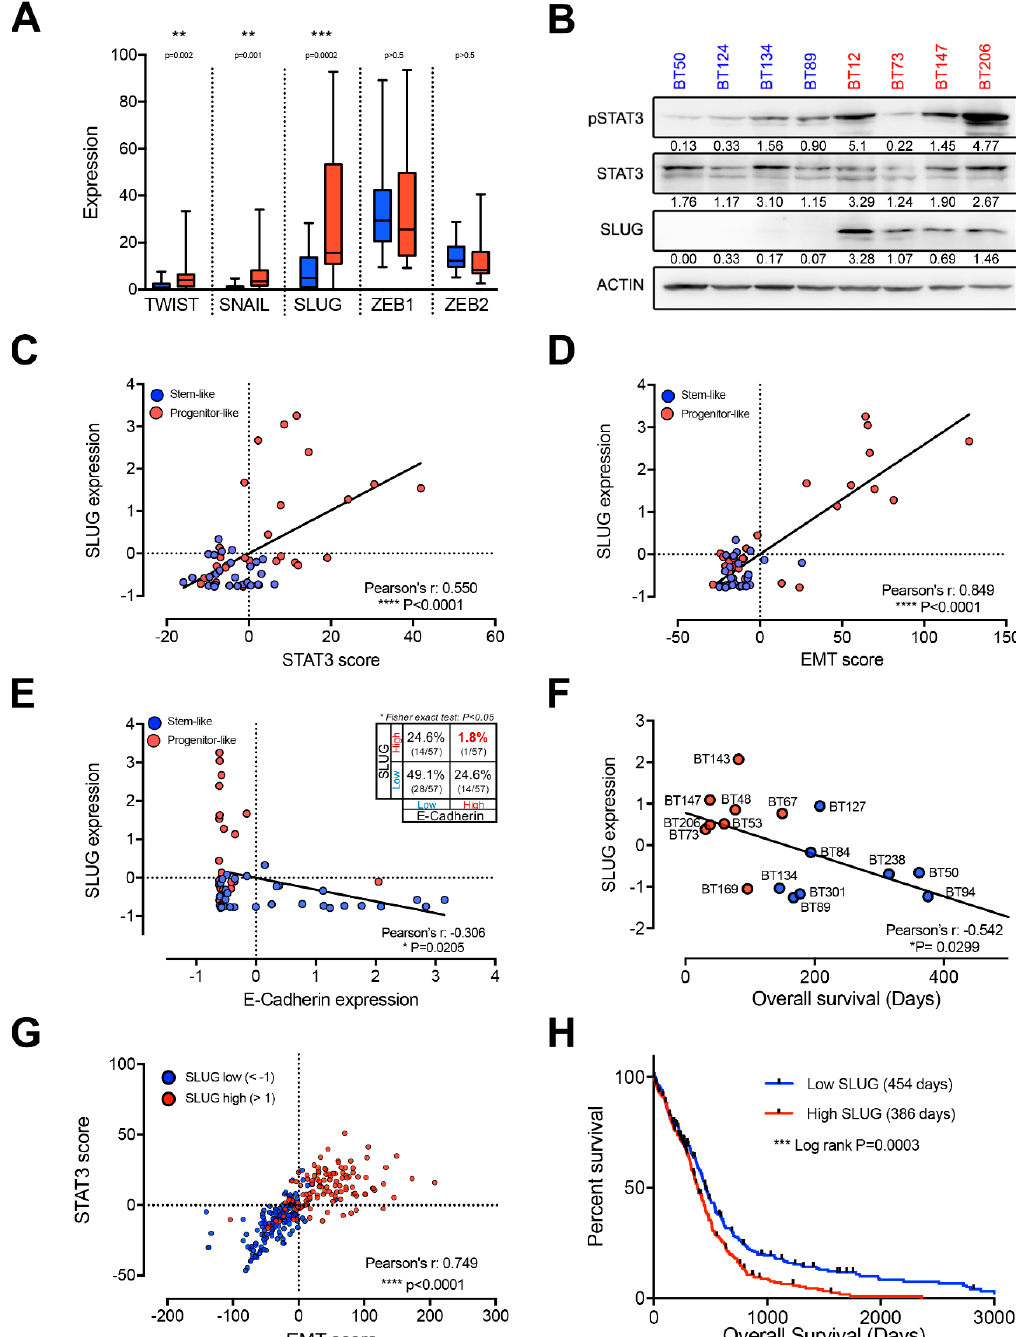
Figure 2. SLUG is the key EMT transcription factor in progenitor-like BTSCs (see also Figure S4). ( A ) Box and whiskers (min to max) plot of the expression of EMT master regulators in stem-like (blue) and progenitor-like (red) BTSCs. ( B ) Representative western blot showing increased activated STAT3 (pSTAT3-Y705) and higher SLUG levels in progenitor-like (red) compared to stem-like (blue) BTSCs. Quantification relative to loading controls. Scatter plots representing the correlation between SLUG expression and ( C ) STAT3 and ( D ) EMT scores. ( E ) Scatter plots showing the mutually exclusive expression of SLUG with E-cadherin in BTSCs segregated as stem-like (blue) or progenitor-like (red). ( F ) Scatter plot illustrating the inverse correlation between expression of SLUG and available BTSC survival data. ( G ) Scatter plot representing the correlation between STAT3 and EMT scores in SLUG high (red, z-score < 1) and SLUG low (blue, z-score > 1) TCGA GBM (glioblastoma) samples (Affymetrix